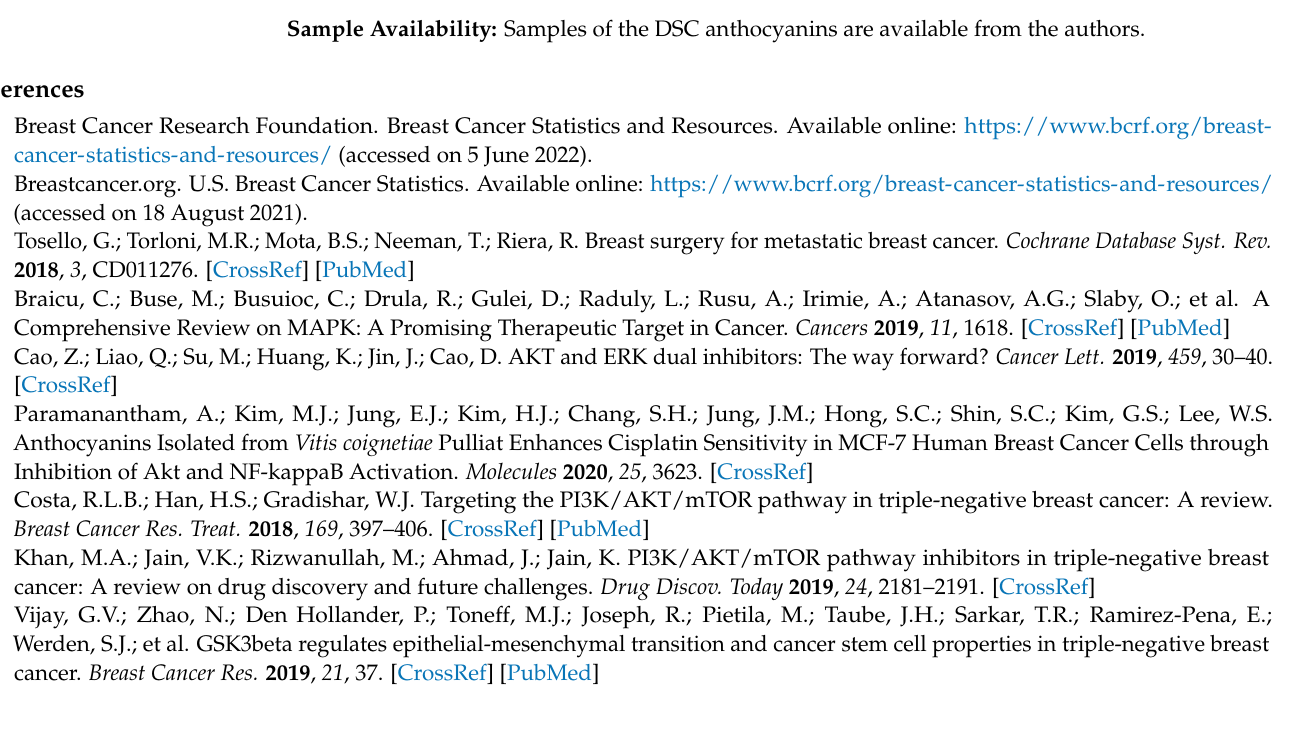
as detailed in materials and methods. Western blots are representative of at least 2 independent experiments. Figure S2: PI3K/Akt/mTOR pathway in TNBC. Figure created in BioRender.com. Figure S3: Levels of p-mTOR/Total mTOR ratio in 4T1 BC cells. Cells starved overnight were treated with ACN (IC50) in 2.5% FBS supplemented culture medium for 48 h. Cell lysates were subjected to immunoblot analysis for p-mTOR or multiplex Magnetic Bead immunoassays for total mTOR as detailed in materials and methods. Data from immunoblot band intensities were divided by MFI data to determine p-mTOR/total mTOR ratio. Data (mean ( n = 2) ± SEM) was analyzed using the t test with Welch’s correction (* p < 0.05). Figure S4. Levels of p-ERK1/2 and p-CREB protein in tumor tissues. Protein levels of p-ERK1/2 (A), and p-CREB (B) in tumor tissues excised after 1-week ACN treatment (150 mg C3G/kg BW/day). Tumor tissues grinded with liquid nitrogen and lysed with xTractor buffer were analyzed as detailed in materials and methods. Western blots are representative of at least 2 independent experiments (upper panel). Band intensities of target proteins determined with ImageJ software were divided by band intensity of β -actin and values were normalized to untreated control (lower panel). Data from relative band intensity determined with ImageJ software are mean ( n = 2) ± SEM. Table S1: Expression levels of total proteins involved in the Akt/mTOR signaling